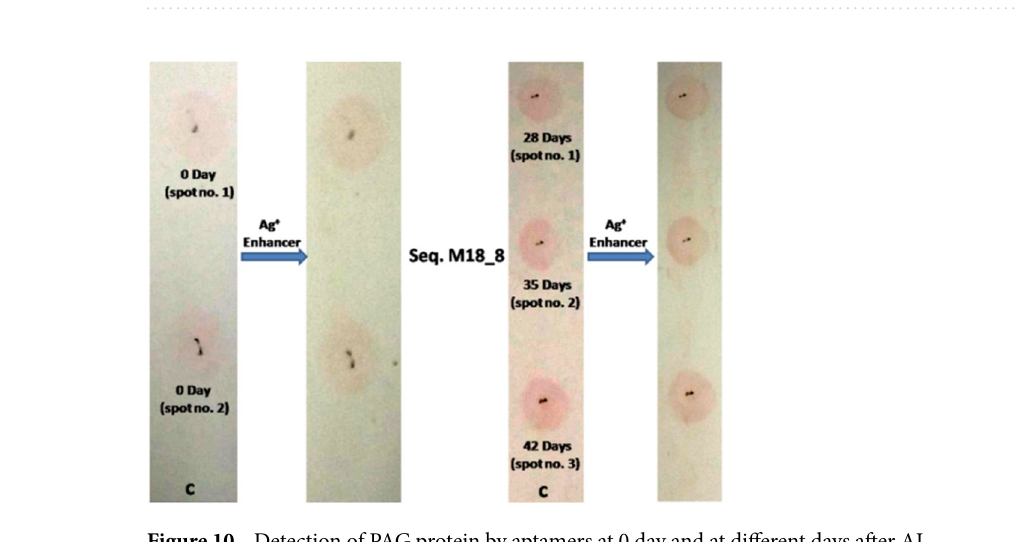
Figure 9. Detection of PAG protein by aptamers in pregnant Water buffalo and postpartum animal.